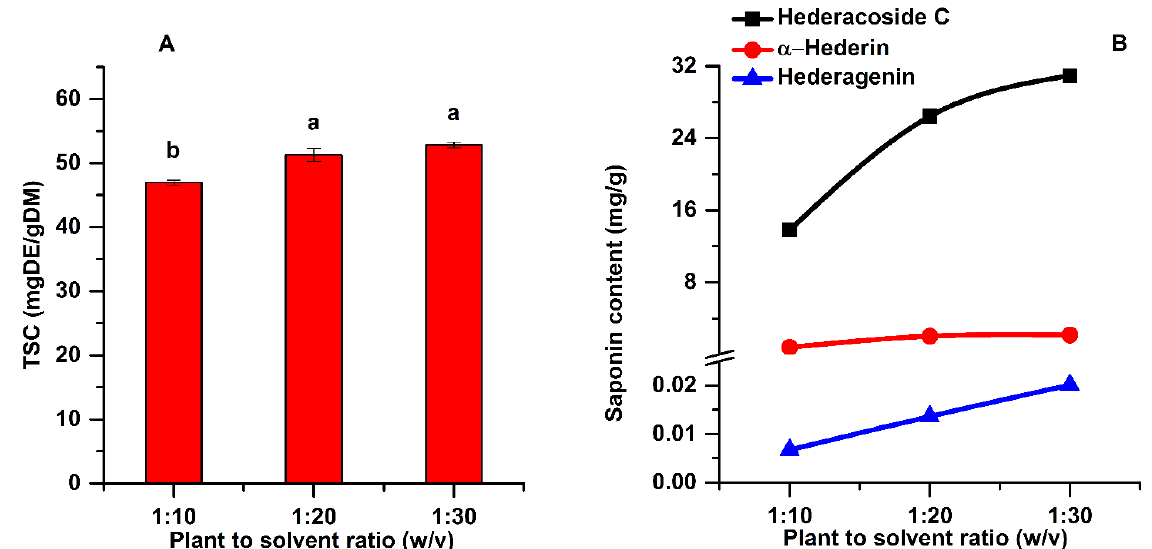
Figure 4. Influence of plant material to solvent ratio on the TSC ( A ) and on the main saponins ( B ) of the extracts (extraction conditions: a temperature of 50 °C, an extraction time of 60 min, continuous sonication, an ethanol concentration of 96%). Data were analyzed using one ‐ way ANOVA ( p < 0.05) and multiple comparison post hoc t ‐ tests (n = 3). Different letters (a,b) within graph shows the significant difference between groups.